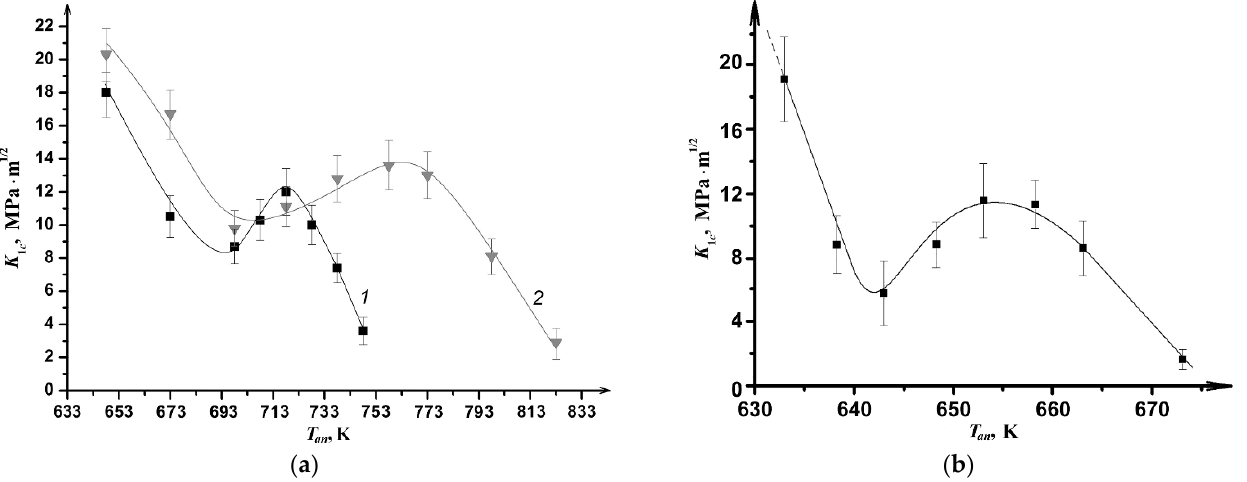
Figure 10. Crack resistance K 1 c behavior of А As subjected to annealing: ( a ) Fe 53.3 Ni 26.5 B 20.2 AA (curve 1 ) and Co 28.2 Fe 38.9 С r 15.4 Si 0.3 B 17.2 AA (curve 2 ); ( b ) Fe 58 Ni 25 B 17 AA. (curve 1 ) and Co 28.2 Fe 38.9 Cr 15.4 Si 0.3 B 17.2 AA (curve 2 ); ( b ) Fe 58 Ni 25 B 17 AA.